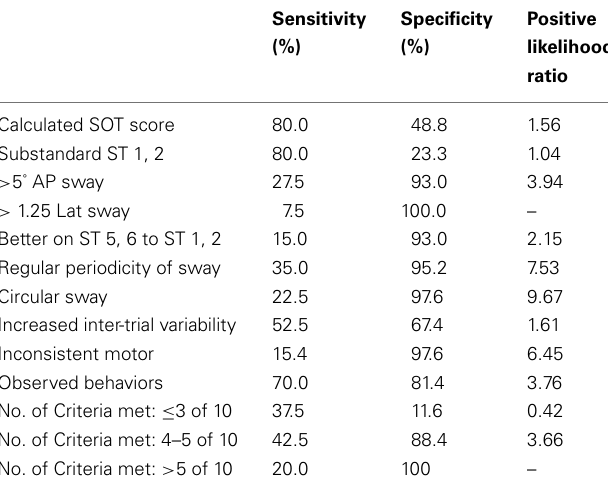
Table 4 | Sensitivity and specificity for each of the CDP and observational behaviors